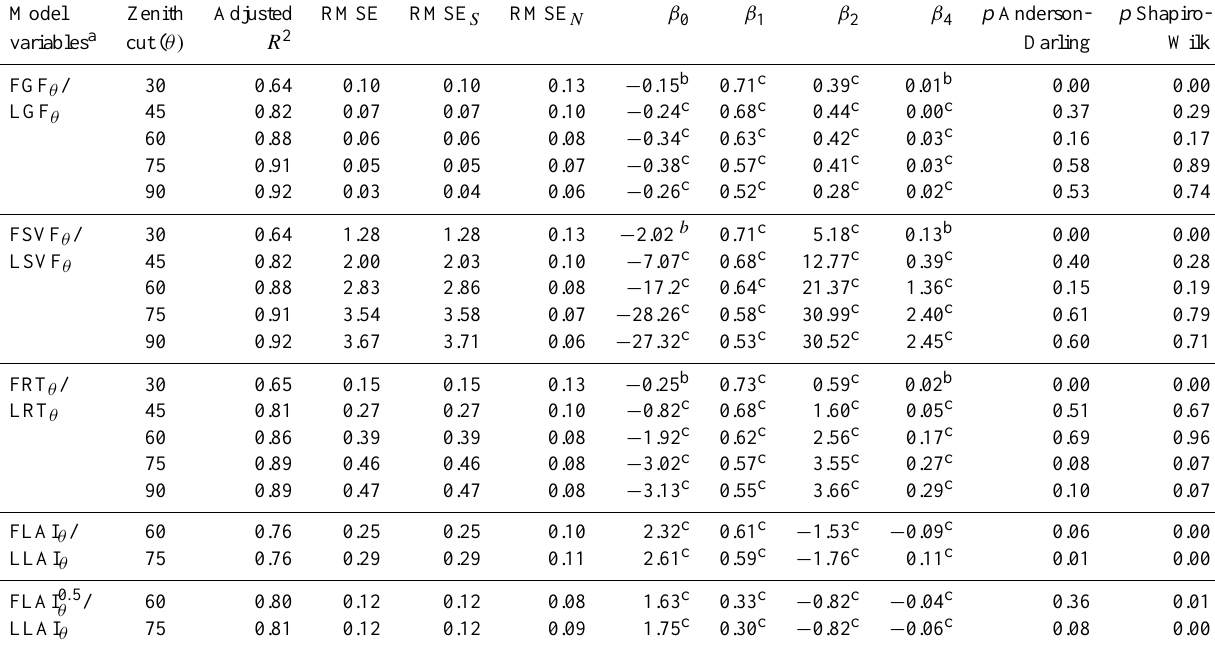
Table 6. Multiple linear regression results (refer to Table 4 for RMSE and RMSE S units).